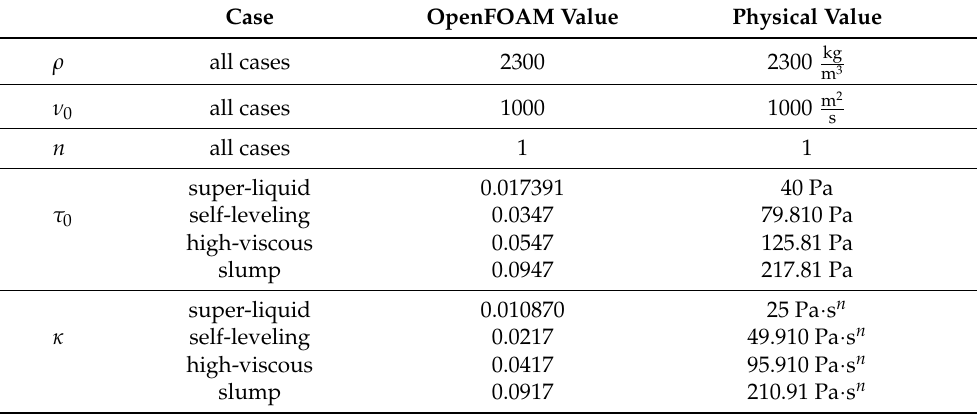
Figure 3. Representation of geometry and mesh of the numerical simulation; the mesh has 7023 nodes and 37,020 cells. Geometry of the beam: W × L × H : 0.15 m × 0.62 m × 0.15 m, inlet centered on the beam axis and 8 cm from the end walls. Modeling and meshing were performed in Gmsh [54]. ( a ) Geometry and mesh of the casting setup, 3D view. ( b ) Geometry and mesh of the casting setup, side view. ( c ) Bottom view of mesh of the casting setup. Table 1. Transport properties used in the OpenFOAM simulation, notation follows the naming in OpenFOAM, i.e., ρ is the density, τ 0 is the yield stress, k controls the viscosity of the flowing mass and ν 0 is the viscosity used if stress is below yield stress. The parameters are in the range published by